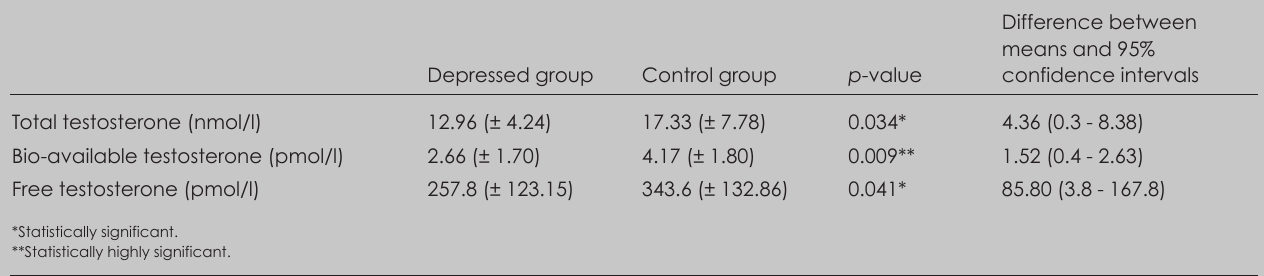
Table I. Mean testosterone concentrations compared by group